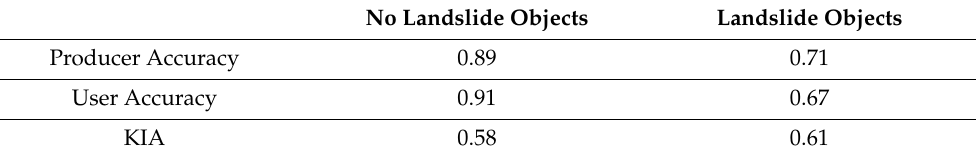
Figure 8. Final map of the detected landslides using OBIA. Table 2. Accuracy assessment (confusion matrix) of the final landslide map.